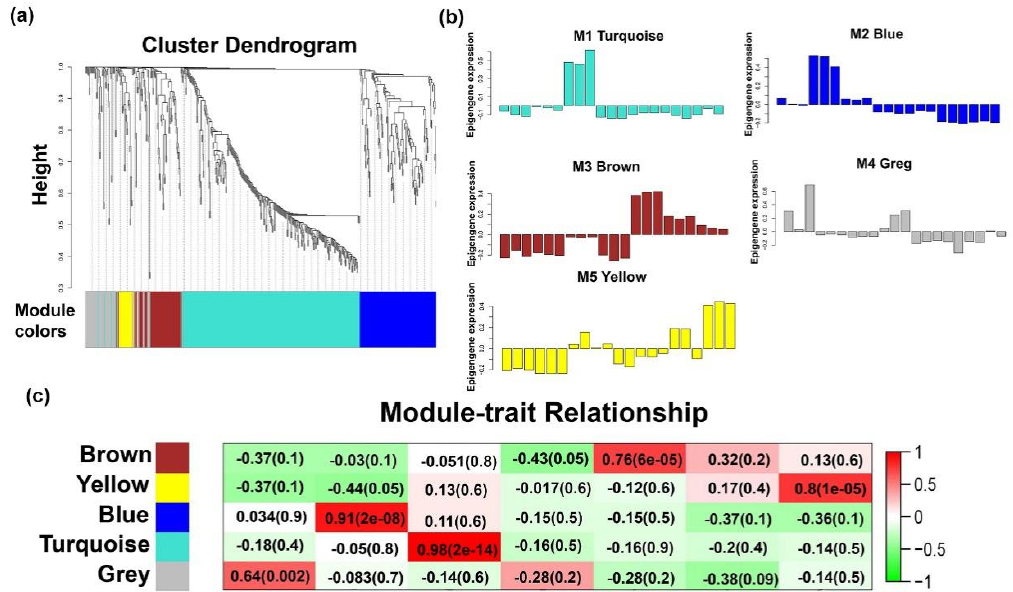
Figure 4. Expression modules of lncRNAs determined by weighted gene co-expression network analysis (WGCNA). ( a ) Hierarchical cluster tree of all di ff erentially expressed lncRNA modules. Modules are corresponded to the branch and are marked by a color, such as color strips under the tree. ( b ) Hierarchical clustering heat map of all di ff erentially expressed lncRNAs by sample. ( c ) Eigengene bar plot of all modules of lncRNAs. The colors correspond to the individual lncRNA modules. The order of the samples is F45, F65, F90, F120, F135, B1, and B90. Each developmental stage contains three biological samples.